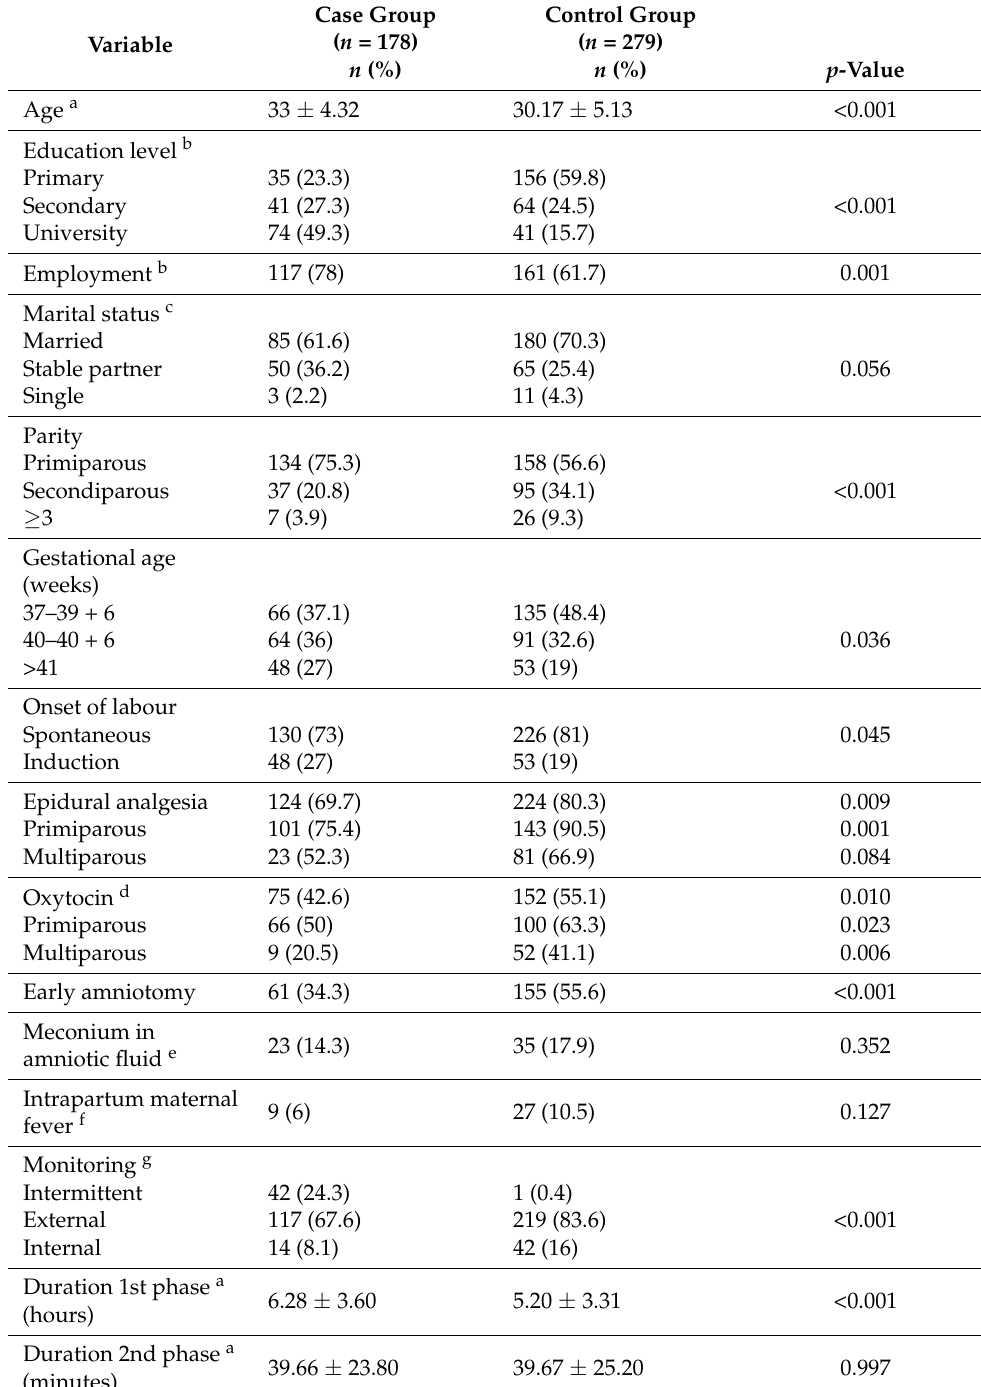
Table 1. Sociodemographic and obstetric characteristics of women with birth plans (case group) and without birth plans (control